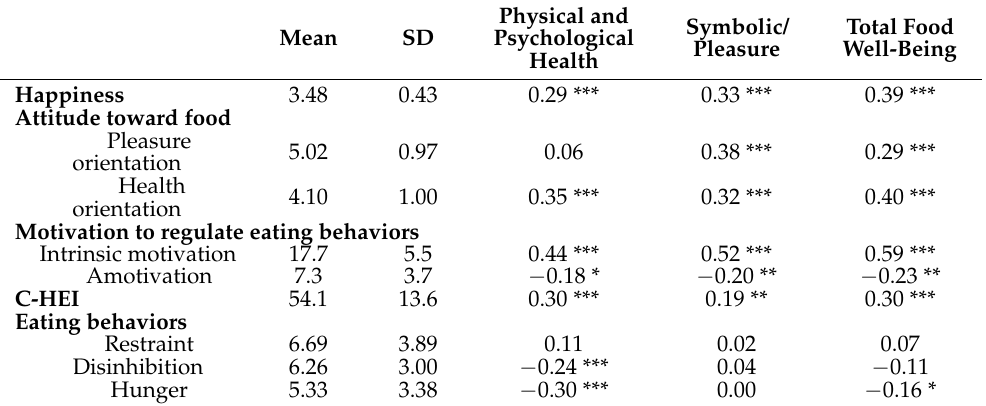
Table 4. Pearson’s correlations between food well-being scores and psychological and eating-related variables, and their means and standard deviations.